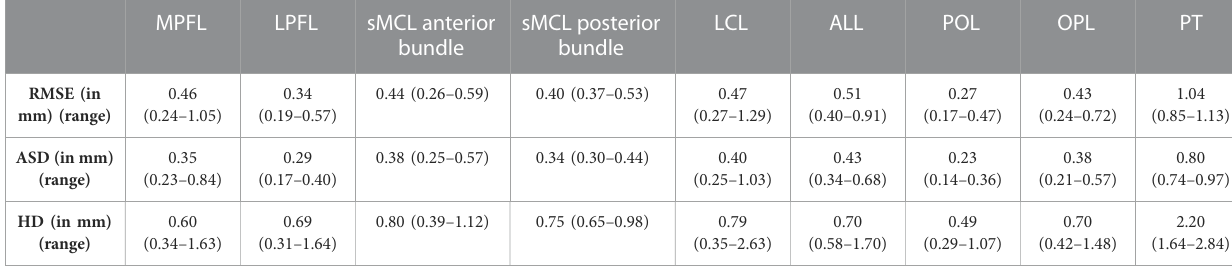
TABLE 4 Median RMSE, ASD and HD with range for the main knee joint ligaments and the patellar tendon course.